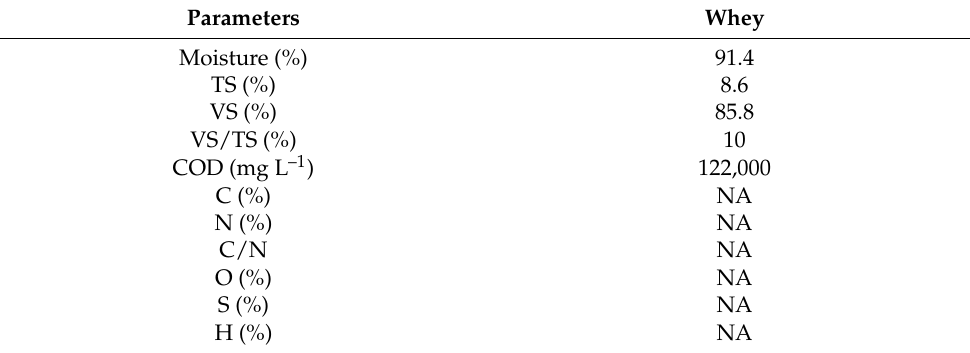
Table 3. Proximate, ultimate, and COD analysis of